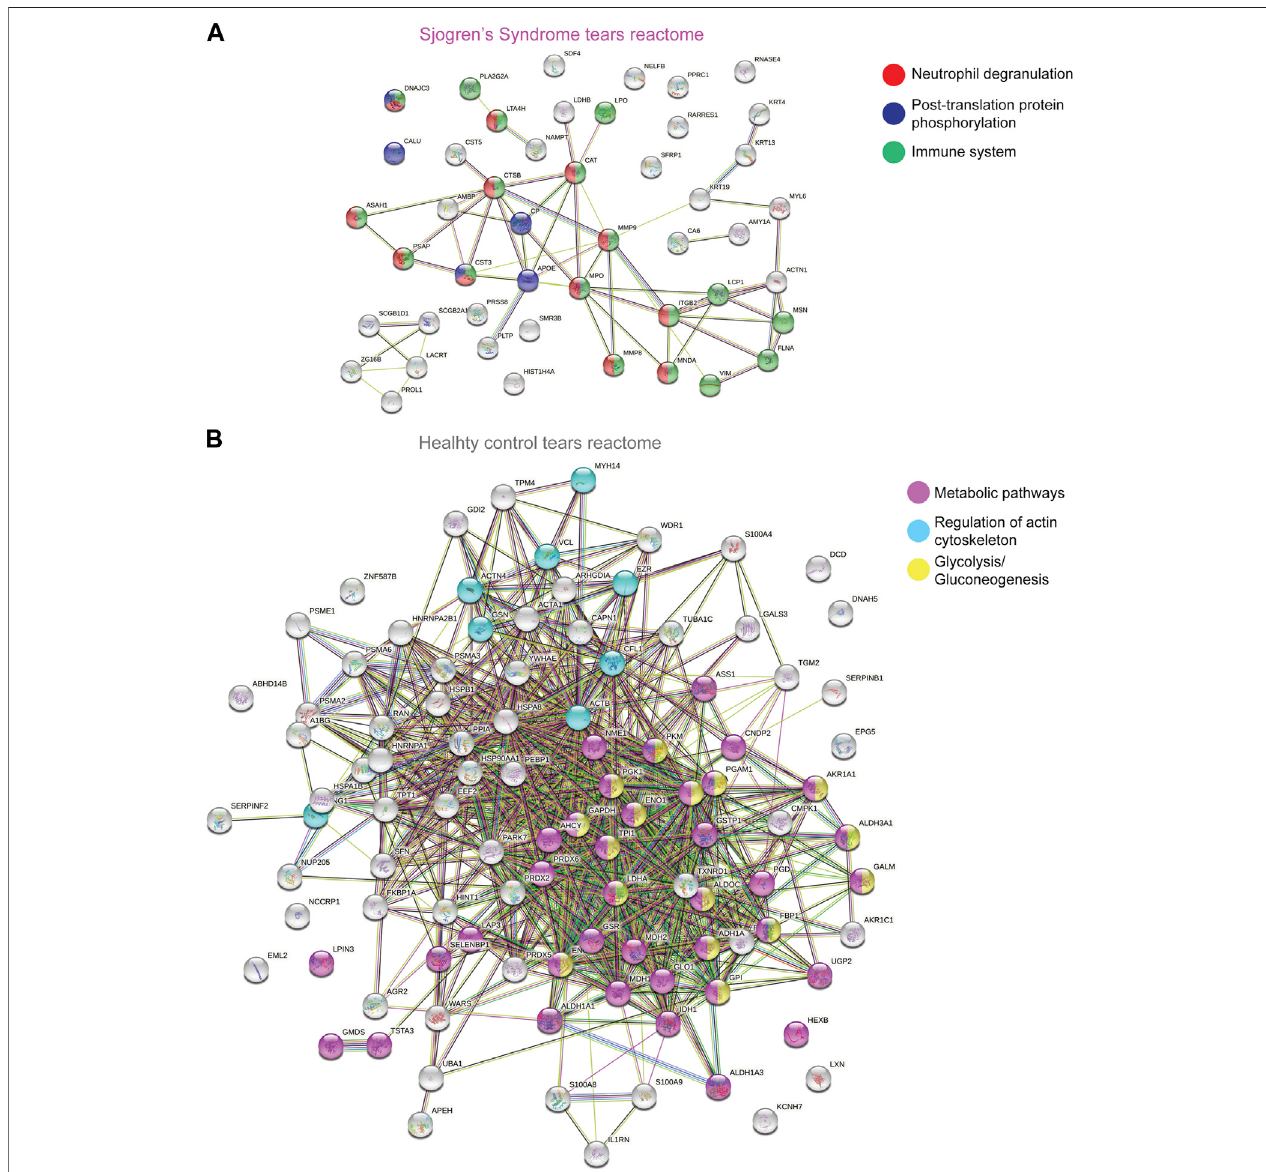
FIGURE 2 | STRING Analysis of Quantitative Proteomics Data of Human Sjogren ’ s Syndrome Tears Washes. Analysis of protein − protein interaction network by STRING v11. Elevated proteins from (A) SS or (B) healthy control tears identi fi ed from the quantitative proteomics analysis were mapped by searching the STRING v11 software with a con fi dence level of 1% false discovery rate. Colored lines between the proteins indicate different types of interaction evidence: known interactions (teal), experimentally determined (pink), predicted interactions gene neighborhood (green), gene fusions (red), gene co-occurrence (blue), text-mining (yellow), coexpression (black), protein homology